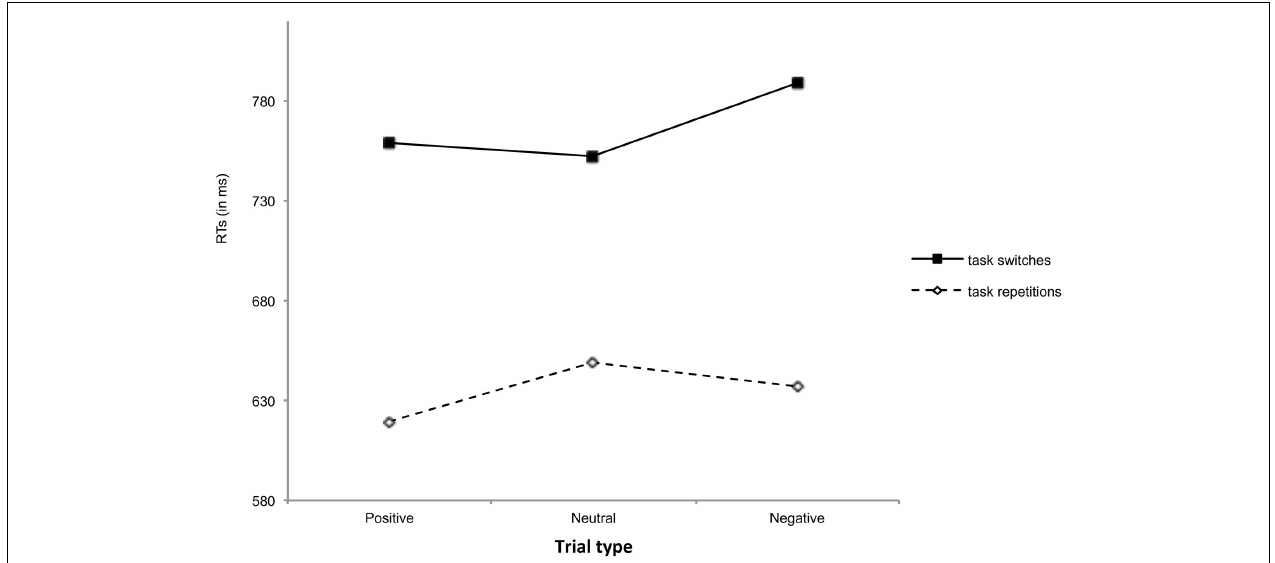
FIGURE 2 | Reaction times as a function of task transition and trial